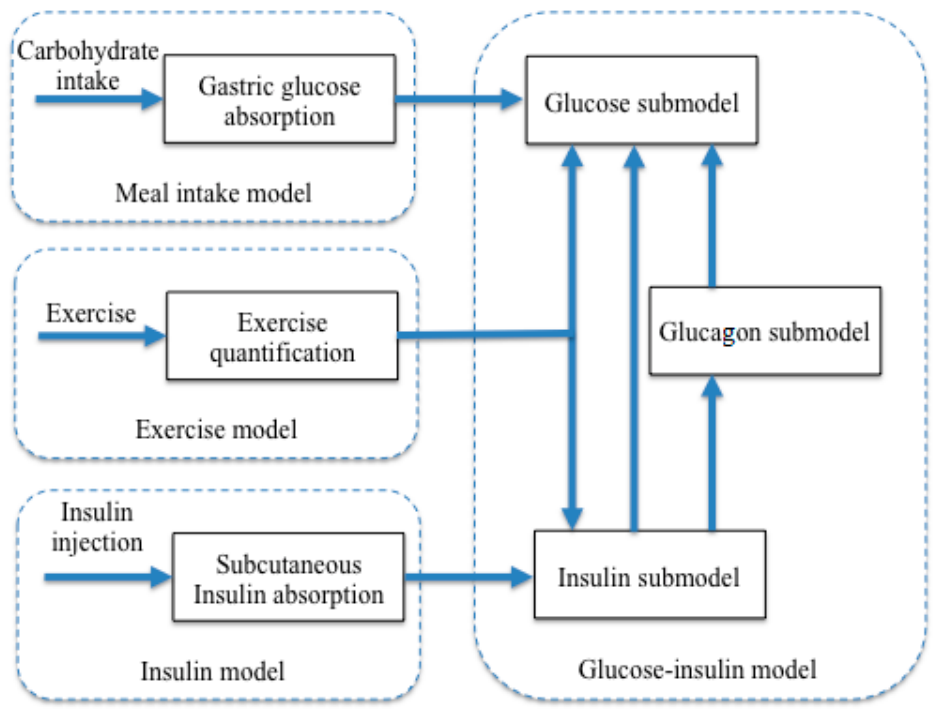
Figure 1. The diabetic patient model utilized for the implementation of simulations reported in this work.